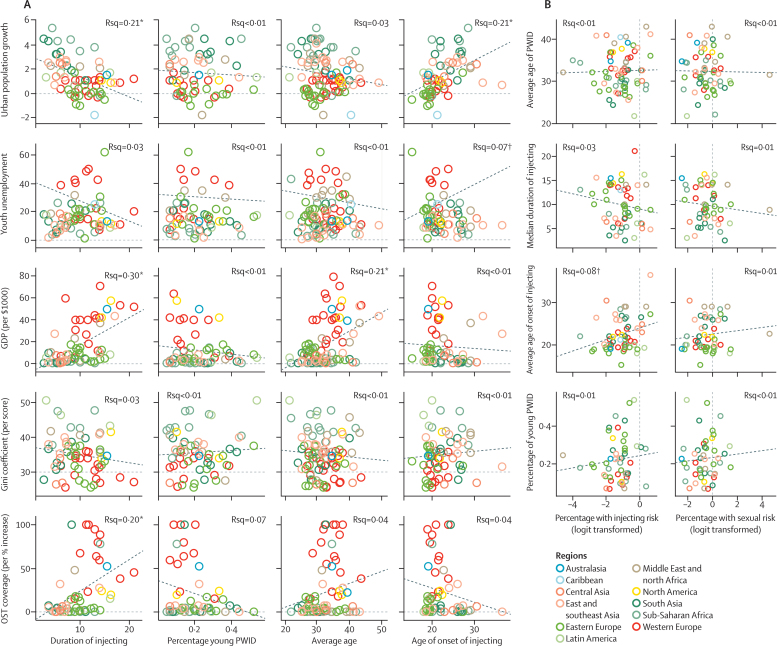
Country-level predictors of indicators of youth injecting drug use (A) and the association between injecting and sexual risk variables and age and injecting history (B)The variables on the percentage of PWID with injecting risk and sexual risk were logit transformed. Rsq gives the R2 value that is proportional to how much of the variability in the dependent variable (eg, duration of injecting) is explained by the independent variable (eg, GDP). GDP=gross domestic product. OST=opioid substitution therapy. *p<0·001. †p<0·05.